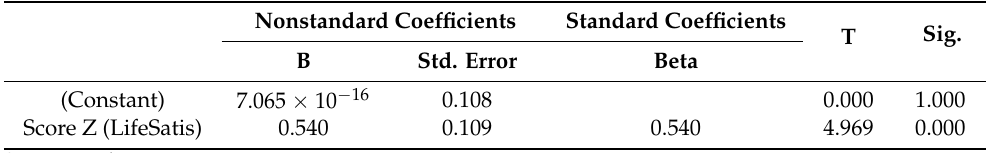
Table 4. Coefficients